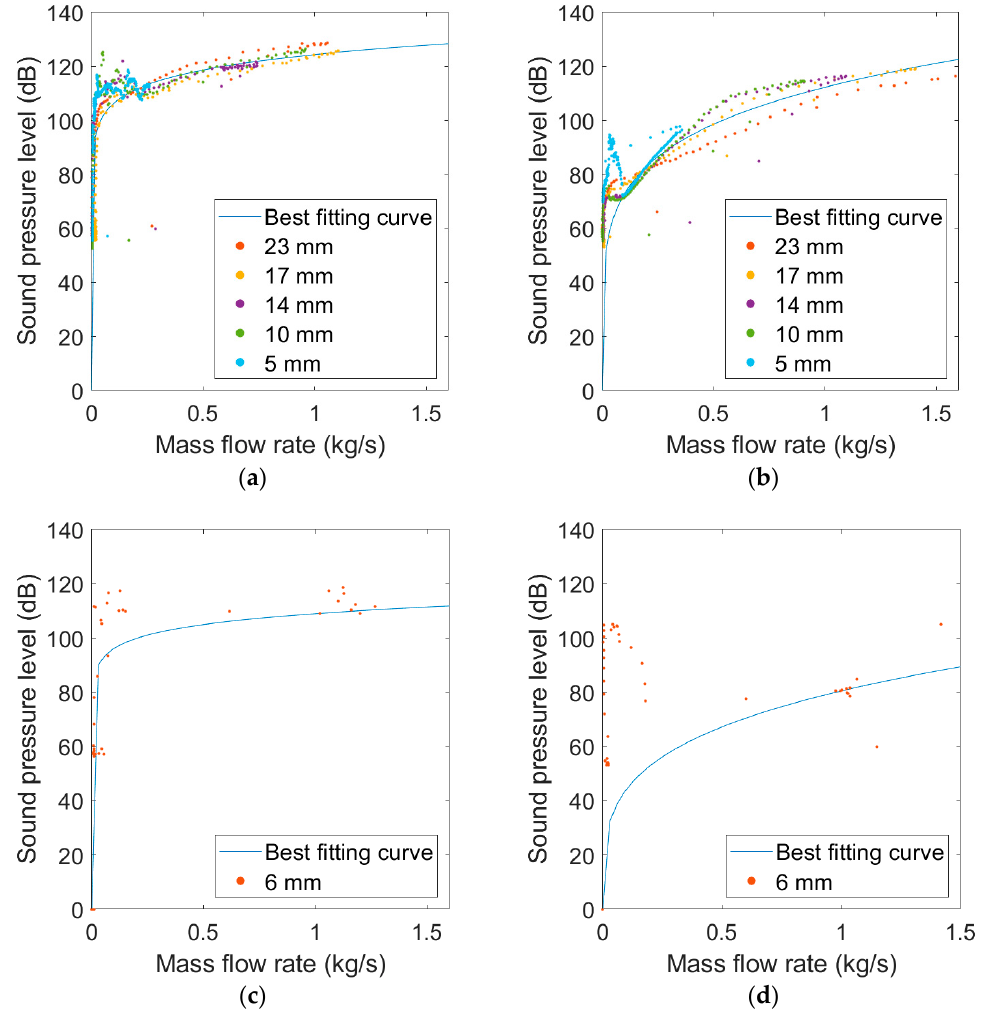
Figure 12. SPL as a function of released mass flow rate, with data points (referred to orifice diameter) and best-fitting curve: ( a ) standard nozzle and nitrogen IG100 discharge; ( b ) silent nozzle and nitrogen IG100 discharge; ( c ) standard nozzle and FK-5-1-12 discharge; ( d ) silent nozzle for low ceiling applications and FK-5-1-12 discharge.